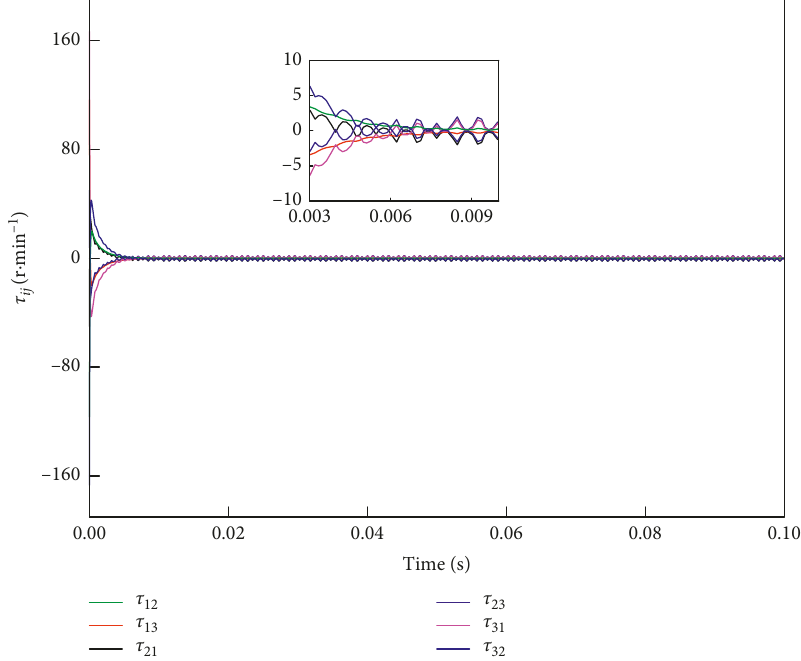
Figure 8: The synchronization error curves of all servos under the traditional PI